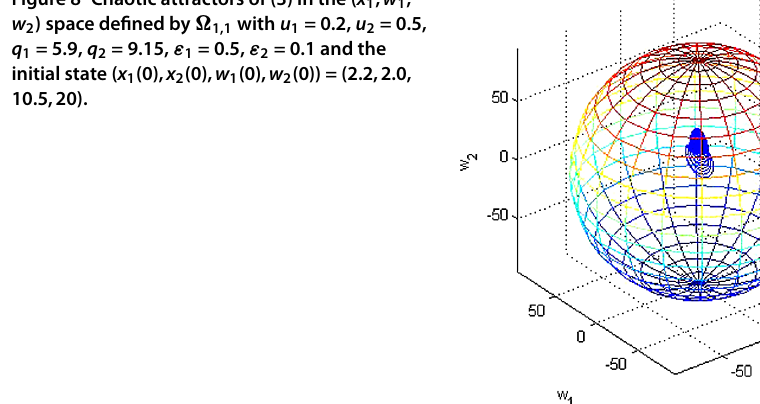
Figure 8 Chaotic attractors of (3) in the ( x 1 , w 1 , w